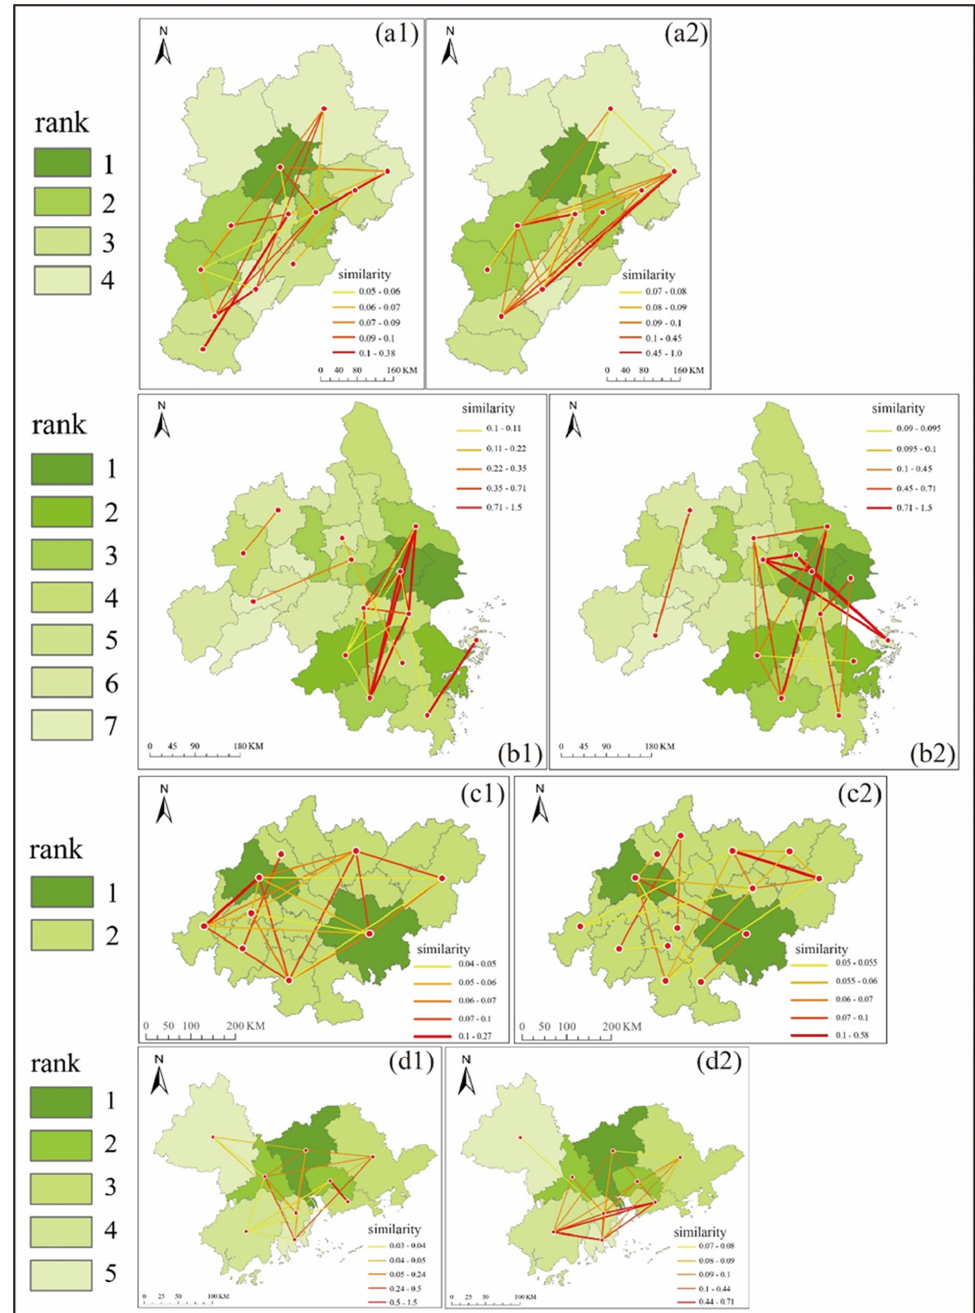
Figure 6. Similarity degree diagram of spatial correlation in functional areas. ( a1 ): Beijing–Tianjin– Hebei, correlation with other functional areas; ( a2 ): Beijing–Tianjin–Hebei, correlation with nonbuilt- up area; ( b1 ): the Yangtze River Delta, correlation with other functional areas; ( b2 ): the Yangtze River Delta, correlation with nonbuilt-up area; ( c1 ): Chengdu–Chongqing, correlation with other functional areas; ( c2 ): Chengdu–Chongqing, correlation with nonbuilt-up area; ( d1 ): the Pearl River Delta, correlation with other functional areas; ( d2 ): the Pearl River Delta, correlation with nonbuilt-up